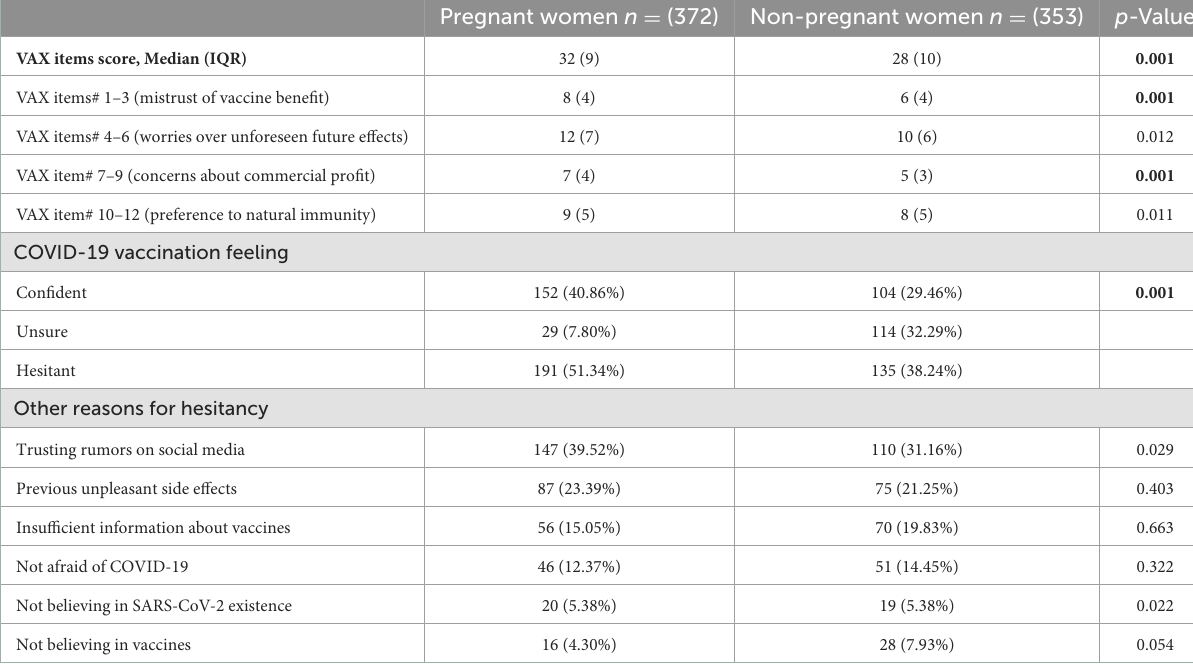
TABLE 2 VAX assessments and reasons for the hesitancy of the study participants.